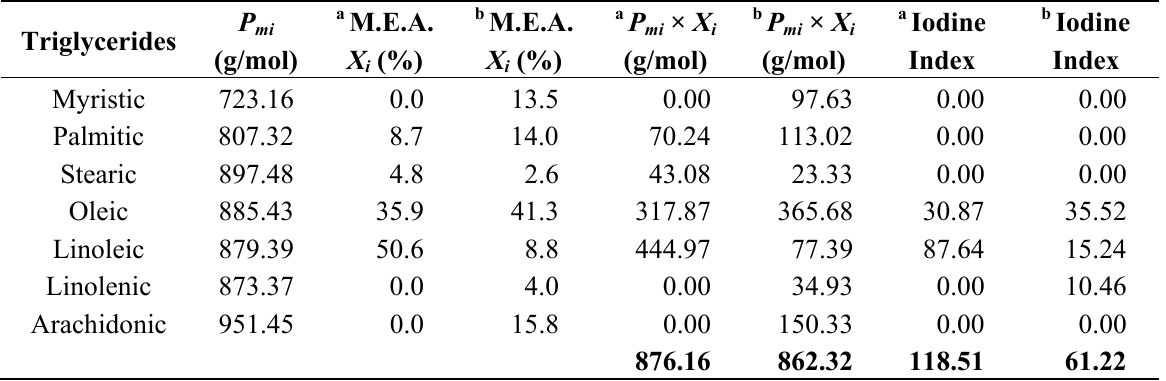
Table 4. Percentage of methyl esters, molecular weight and iodine index of algae oil and sunflower